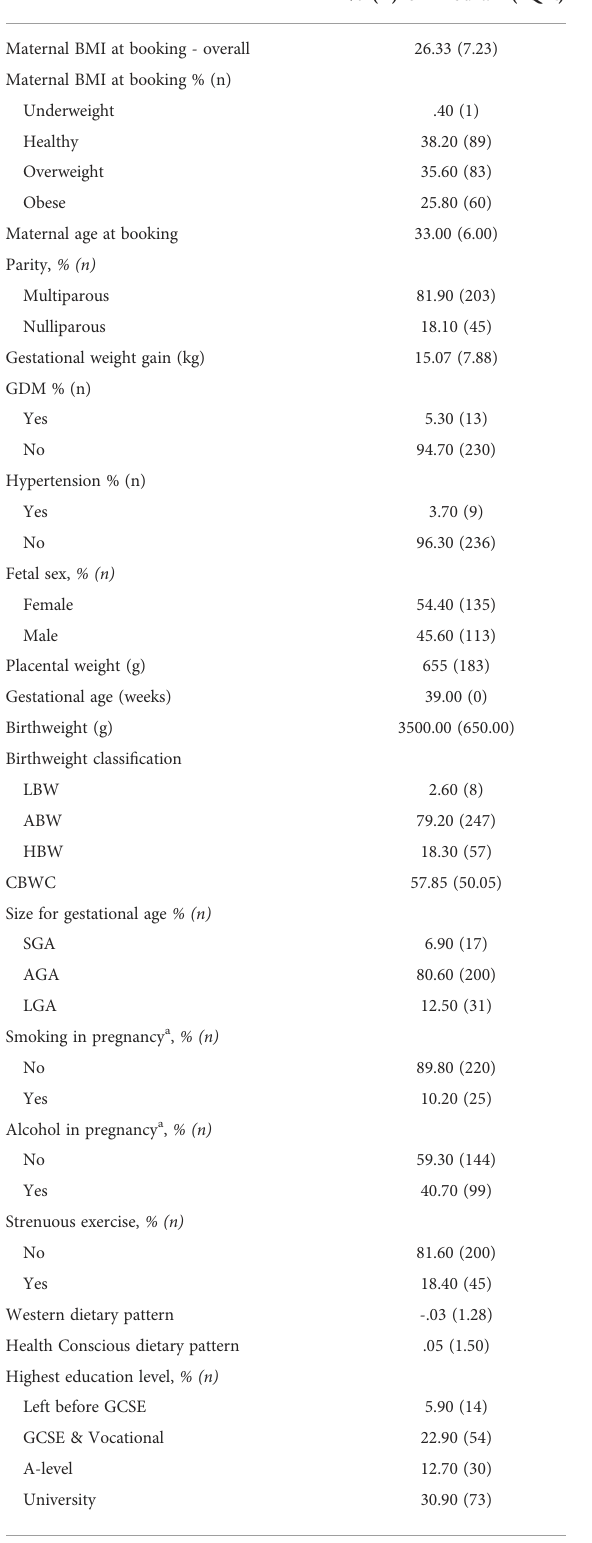
TABLE 1 Demographic data for the eligible GiW